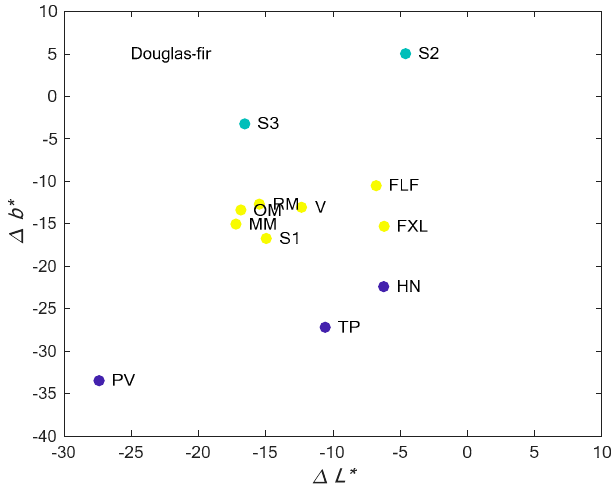
Figure 4. Cluster results plotted on the ∆ L * and ∆ b * axes. The cluster solution utilizes linkage distances calculated with MANOVA using 18-month ∆ L *, ∆ a *, and ∆ b * values for Douglas-fir.